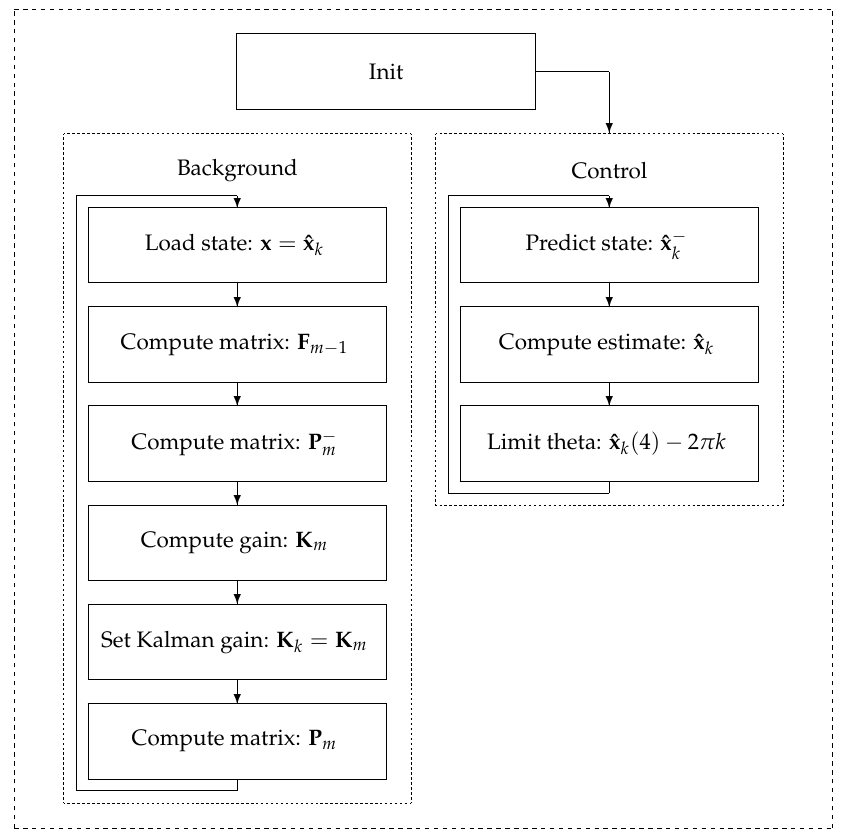
Figure 2. Flow diagram ot the EKF algorithm with parallel